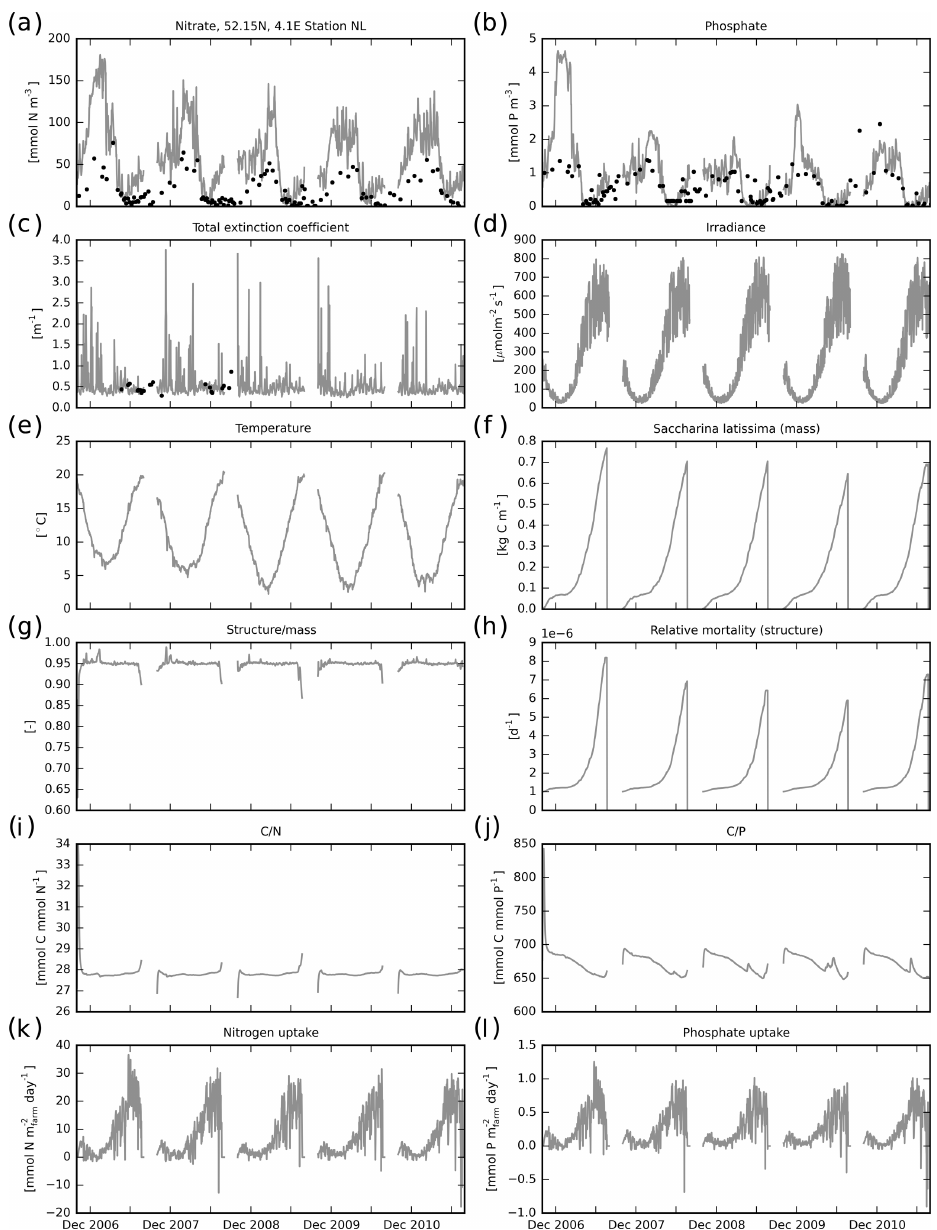
Figure 12. Model results for the Rhine plume farm site. (a) Surface nitrate concentration; (b) surface phosphate concentration; (c) total extinction coefficient at the surface (excluding contribution by macroalgae); (d) irradiance at the surface; (e) surface water temperature; (f) macroalgae carbon biomass per metre of line; (g) mass of macroalgae structure over total macroalgae mass ratio; (h) relative mortality of macroalgae structure; (i) C / N ratio of macroalgae; (j) C / P ratio of macroalgae; (k) farm net nitrogen uptake; (l) farm net phosphate uptake. Black dots are observations from the nearby Noordwijk transect at 10km offshore collected by RIKZ